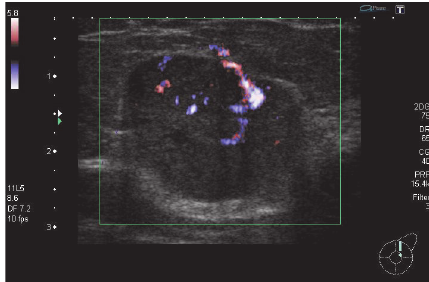
Figure 1: A breast ultrasonography image shows well-demarcated, highly abundant blood flow and a cystic lesion. These findings suggest a breast tumor with malignancy.